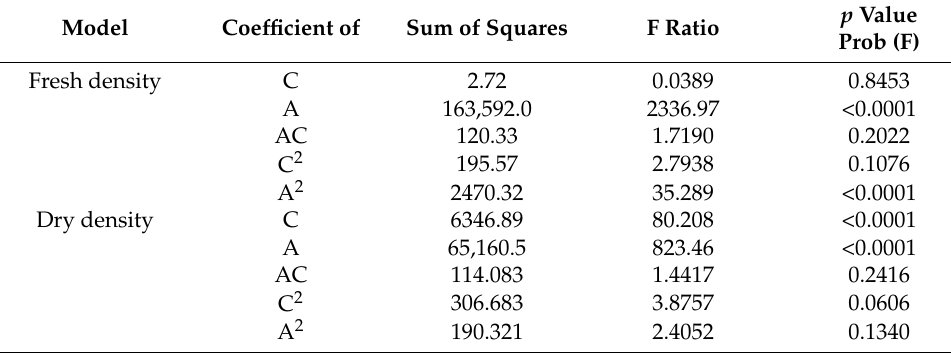
Table 11. ANOVA results for fresh and dry density regression coefficients.